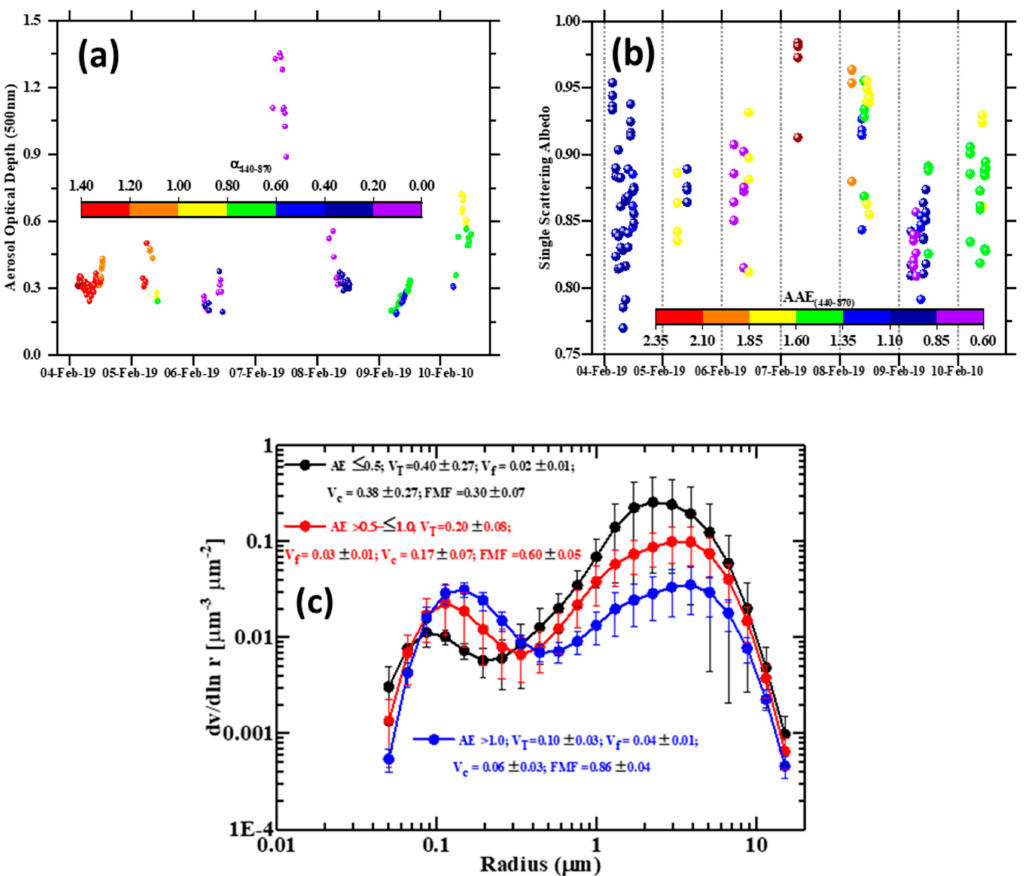
Figure 11. ( a ) Time series of the AOD 500 values as a function of AE 440–870 (colored scale); ( b ) single scattering albedo (SSA) as a function of AAE 440–870 ; and ( c ) volume size distributions grouped for three AE 440–870 clusters (AE < 0.5, 0.5 < AE < 1.0, AE > 1.0) at Karachi AERONET station during 4–10 February